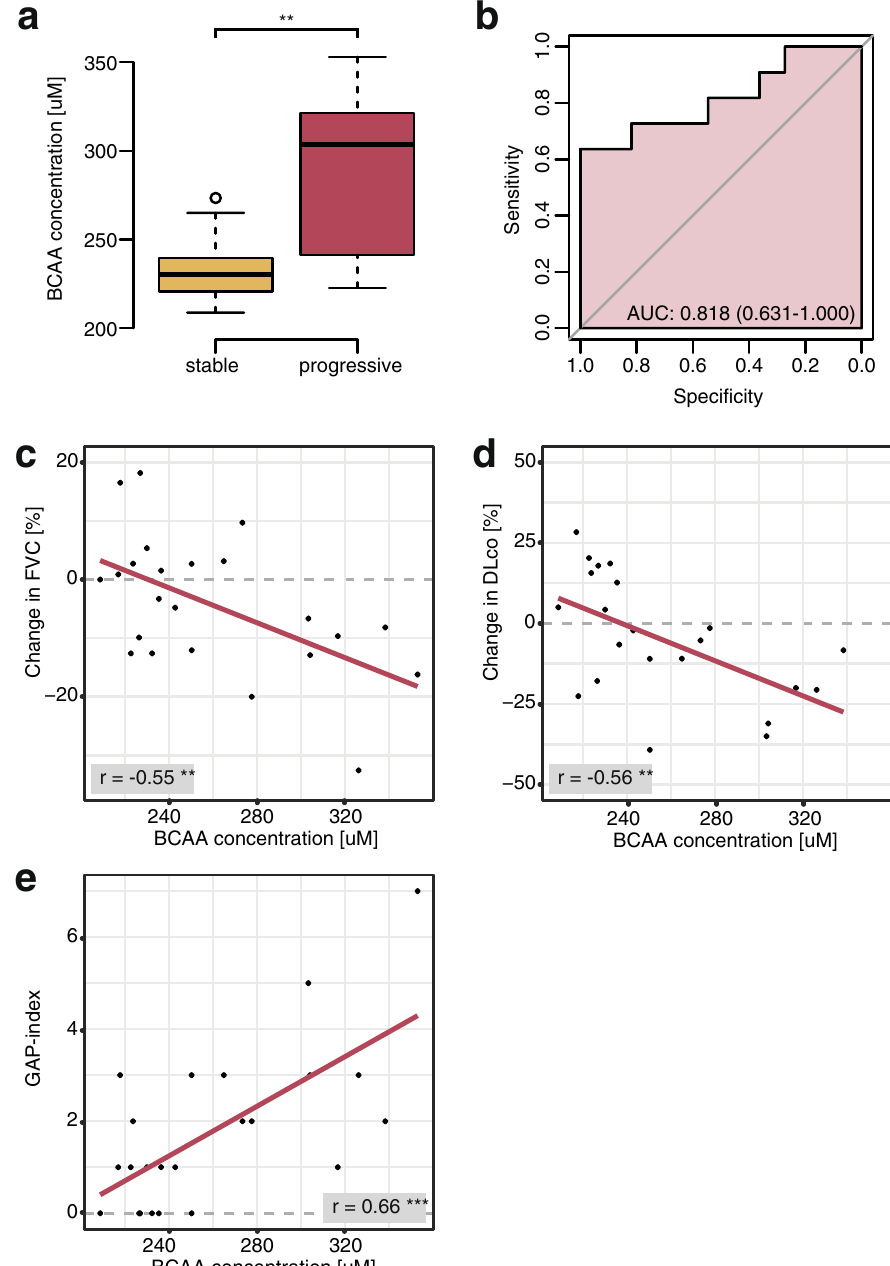
Figure 7. Results of t-test ( a ), ROC analysis ( b ), and Pearson’s correlation analysis ( c , d ) of enzymatic analysis of BCAA levels in SSc-ILD patients. **p ≤ 0.01. N = 11 (progressive) and 12